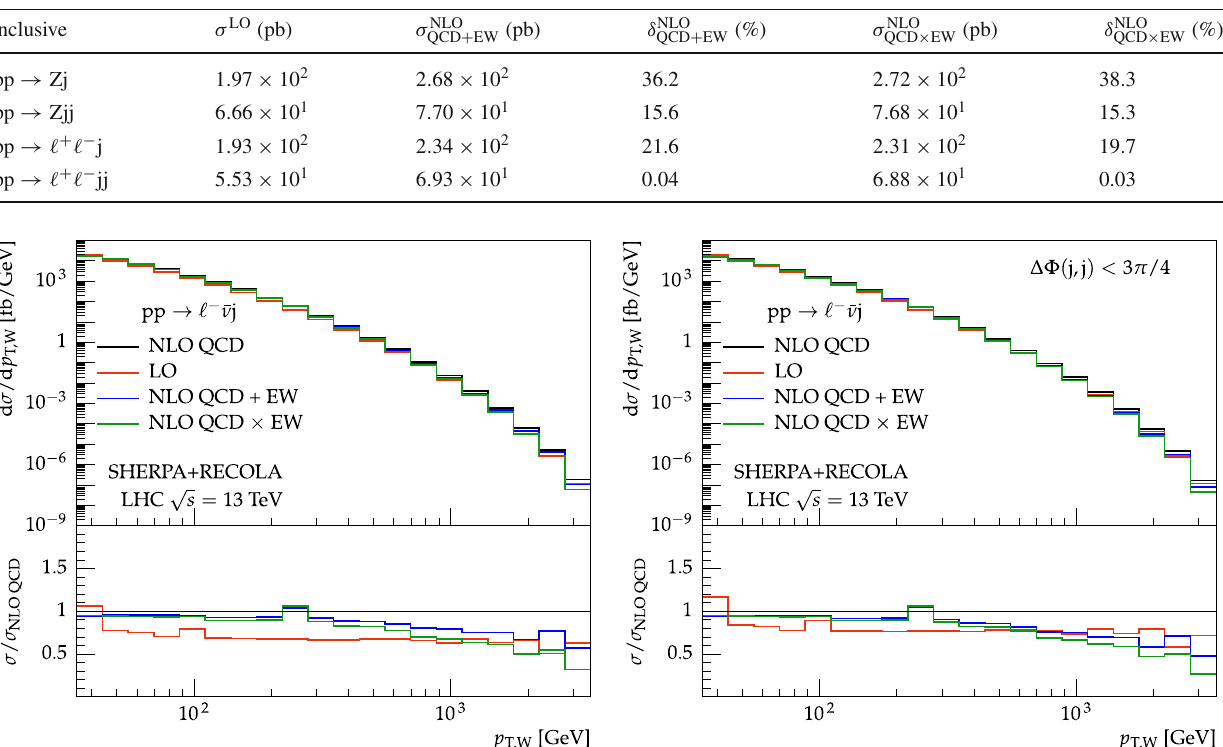
Fig. 9 Differential distributions at 13TeV for off-shell W + j production at the LHC. The left-hand plot shows the p T of the reconstructed W boson with minimal cuts and the right-hand plot the result with a cut of (cid:5)(cid:12)( j , j ) < 3 π/